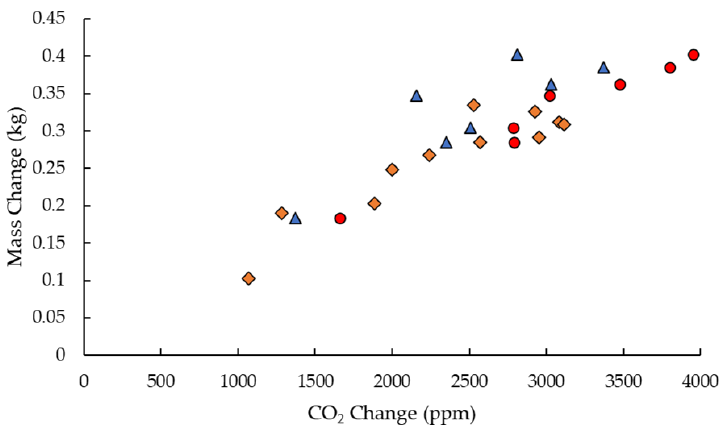
Figure 6. Using data similar to that shown in Figure 5, daytime change in mass due to foragers leaving the hive is plotted against the change in CO 2 at the same time. Data for three hives sensors are shown: HPP8 crown board (diamonds), HPP6 queen excluder (circles), and HPP6 crown board (triangles).